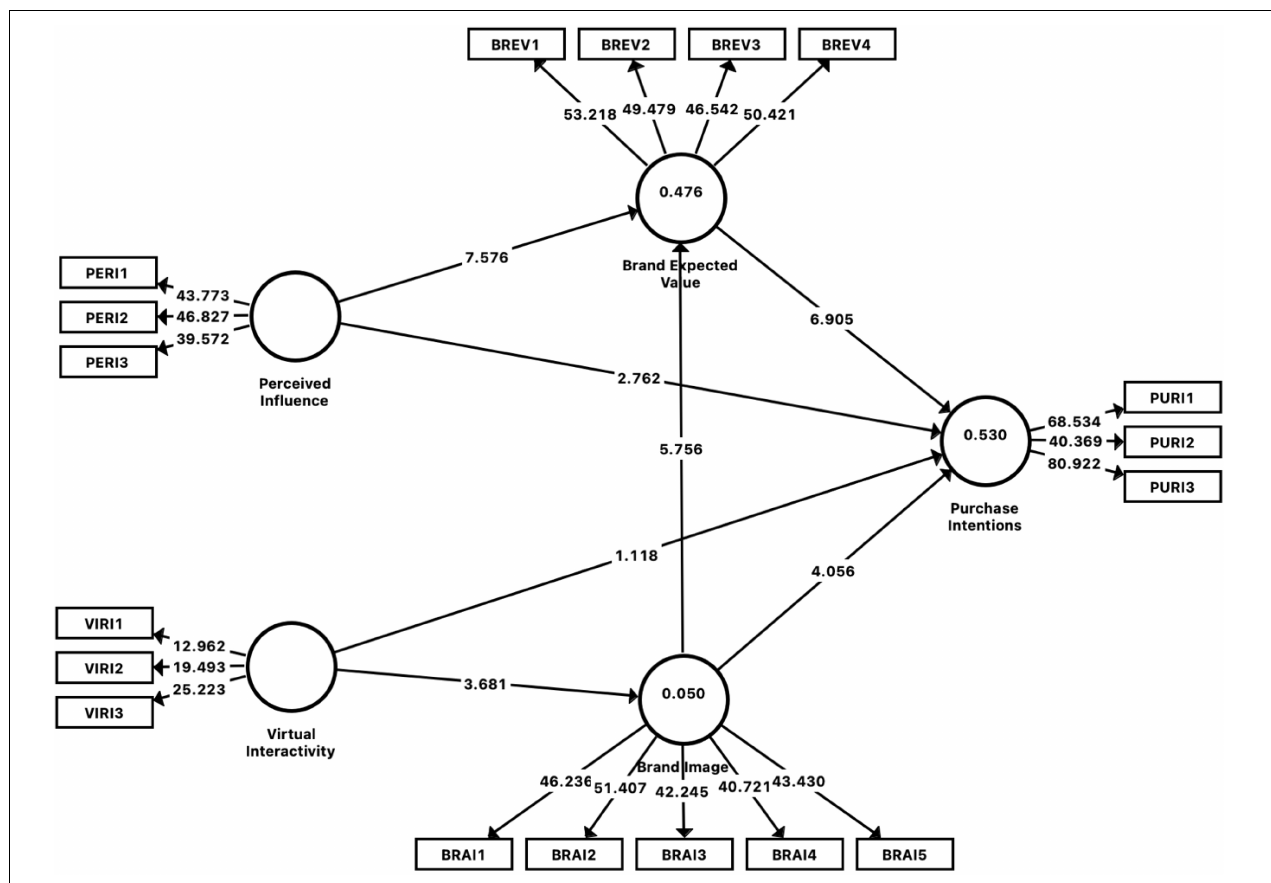
FIGURE 1 | Structural model assessment.